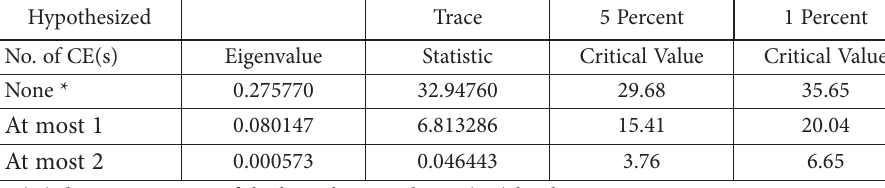
Table A6. Unrestricted cointegration rank tests (source: authors’ computations)